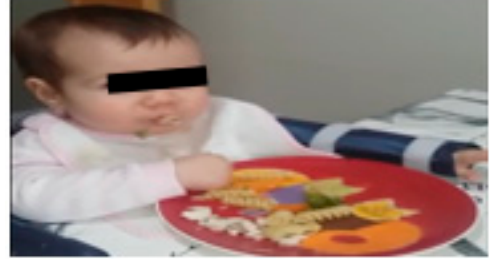
Figure 10. Constraint-induced movement therapy.